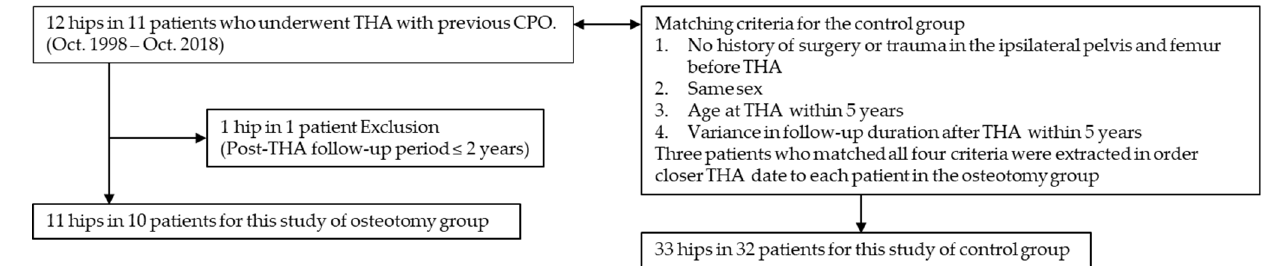
Figure 1. Patient selection workflow. Abbreviations: THA, total hip arthroplasty; CPO, curved periacetabular osteotomy.